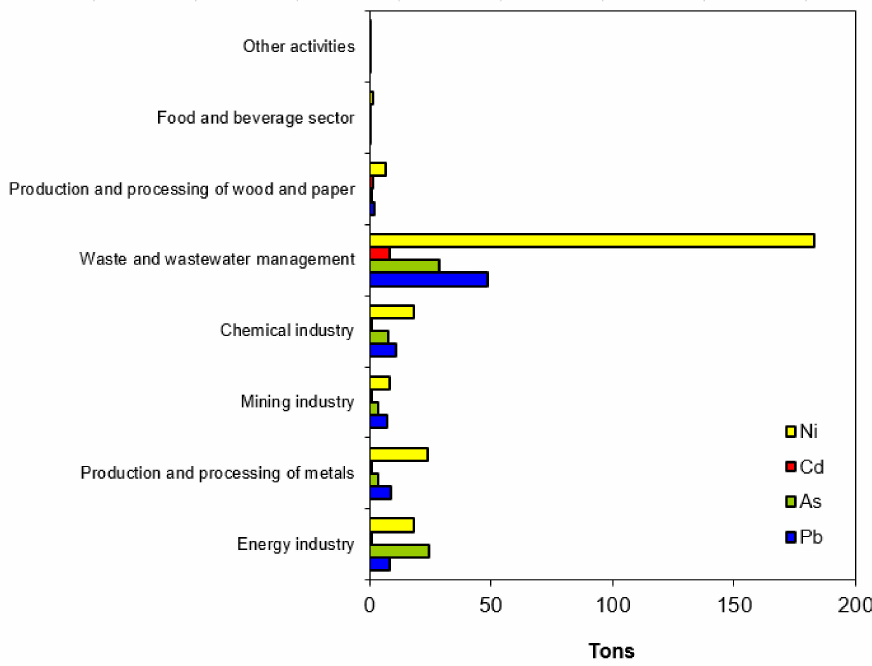
Figure 2. The contribution of various sectors of anthropogenic activity to the contamination of aquatic environments with heavy metals in